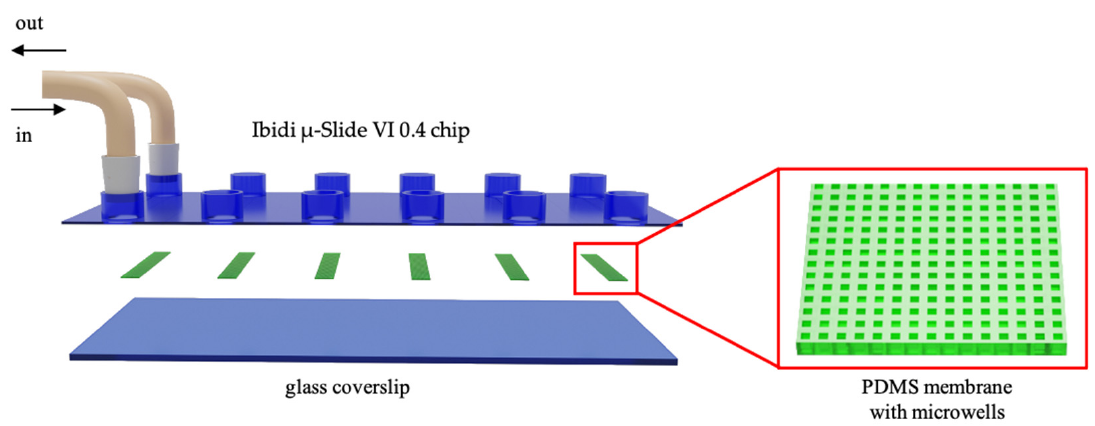
Figure 1. Assembly of the microfluidic chip for cellular nanomotion measurement. The bottom of the chip is composed of 6 PDMS membranes attached to a glass coverslip in such a way that they are aligned with the 6 channels of a sticky Ibidi µ -Slide VI 0.4 chip, used as the top plate. Each PDMS membrane consists of a 20 × 87 array of